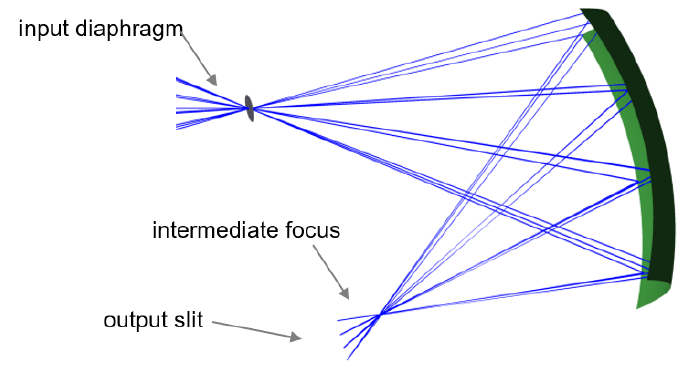
Figure 10. Side view of the setup, showing a tight intermediate focus.